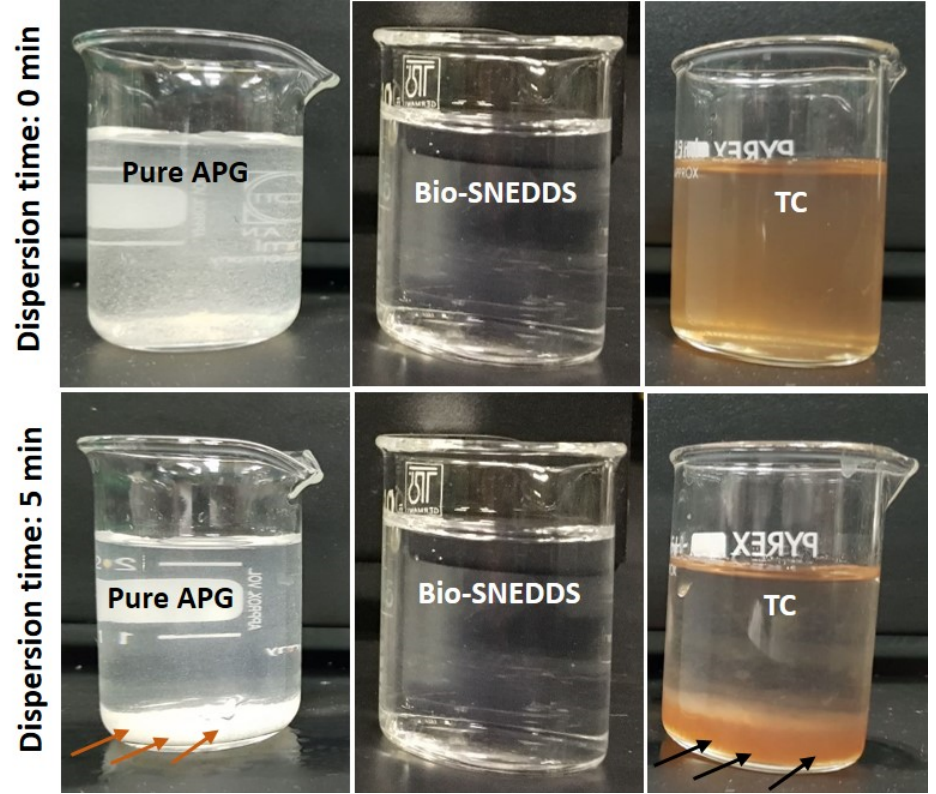
Figure 5. Appearance of pure APG powder and the representative formulations upon aqueous dilution with water after the initial and 5 min dispersion time. Arrows show the sedimentation/precipitation of APG after aqueous dispersion.